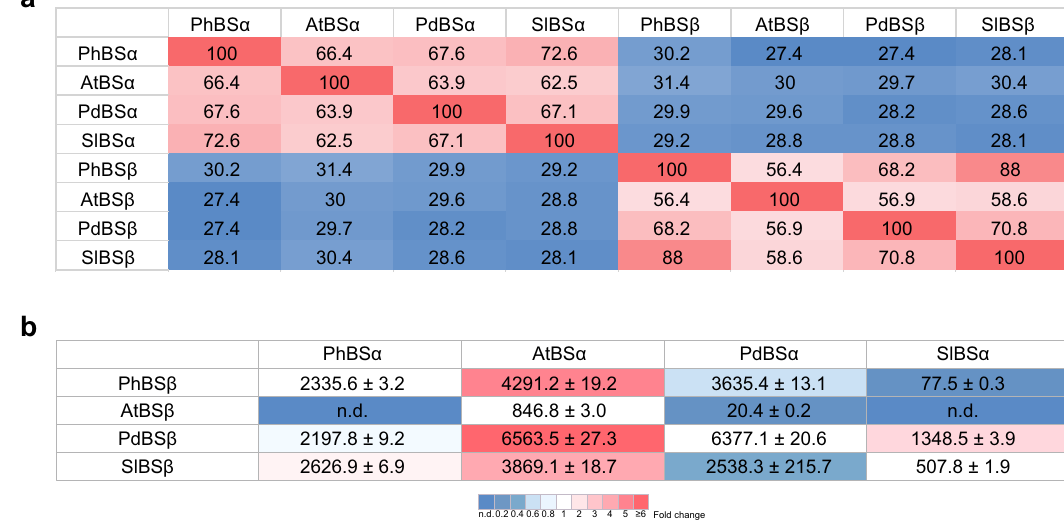
Fig. 6 Cross-species interactions of BS subunits. a Protein sequence identity matrix between BS subunits from petunia (PhBS), Arabidopsis (AtBS), almond (PdBS) and tomato (SlBS). Cells are colored based on sequence identity from the lowest (blue) to the highest (red). b Apparent activities of cross- species BS heterodimers. Freshly puri fi ed recombinant proteins were mixed at 1:1 ratio and incubated on ice overnight before standard BS activity assays. Data are means ± SD ( n = 3 technical replicates). Cells are colored based on fold changes of activities of each α subunit with varies β subunits relative to its original BS activity in each